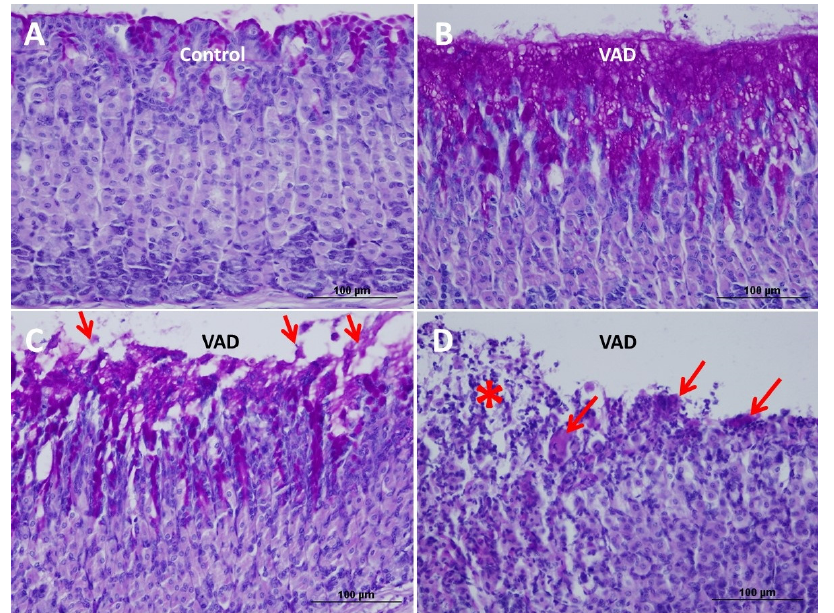
Figure 5. Gastric mucosal tissue sections obtained from 8-month control ( A ) and VAD ( B – D ) mice stained with PAS and hematoxylin. ( A ) Control tissue with PAS-positive mucous cells which appear purple at the luminal surface and along the short pits. ( B ) VAD mucosal tissue with massive amount of PAS-stained mucus seen at the luminal surface and along the pits. ( C ) VAD gastric mucosa with sloughing of the PAS-stained mucus and cells (arrows) at the luminal surface. ( D ) VAD gastric mu- cosa showing loss of surface integrity with sloughing cells (asterisk) and mucinous clumps (arrows) with leucocytic infiltration in the mucosa. Scale bars =100 µm ( A – D ).